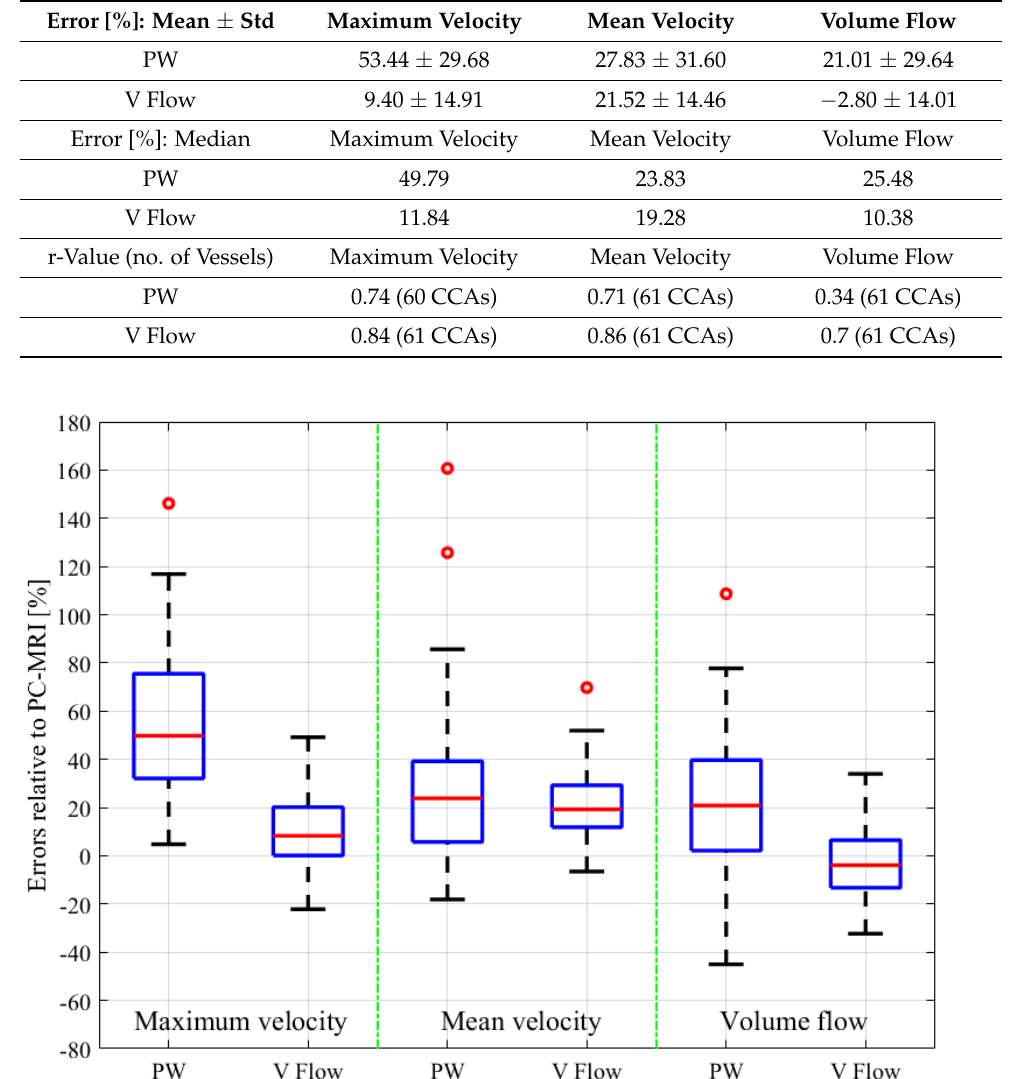
Table 1. The mean error with standard deviation (Std), the median of absolute errors, and the r-value of V Flow and PW relative to the PC-MRI results.